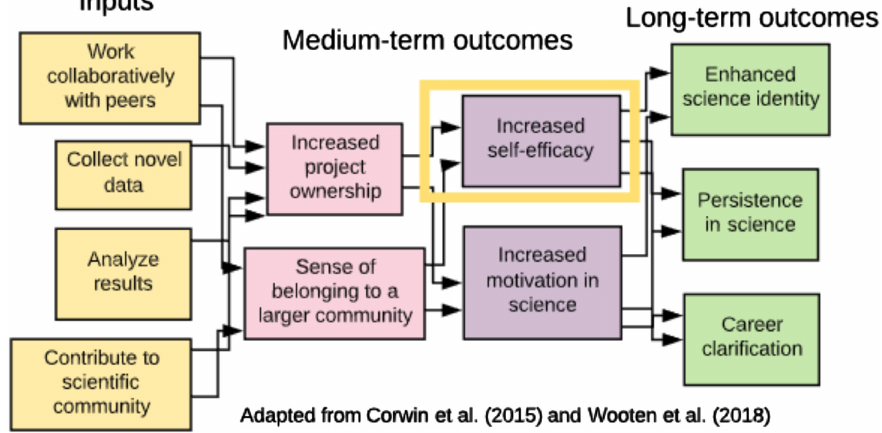
FIG. 1. Diagram of how research experience inputs influence medium- and long-term outcomes for students. Increased self-efficacy leads to enhanced science identity, persistence in science, and increased STEM career